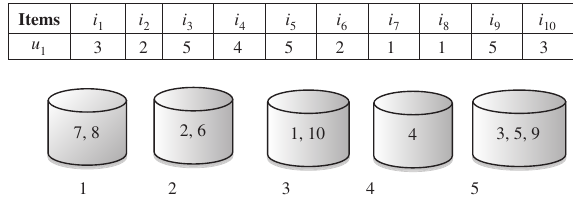
Figure 1: Bucket Order